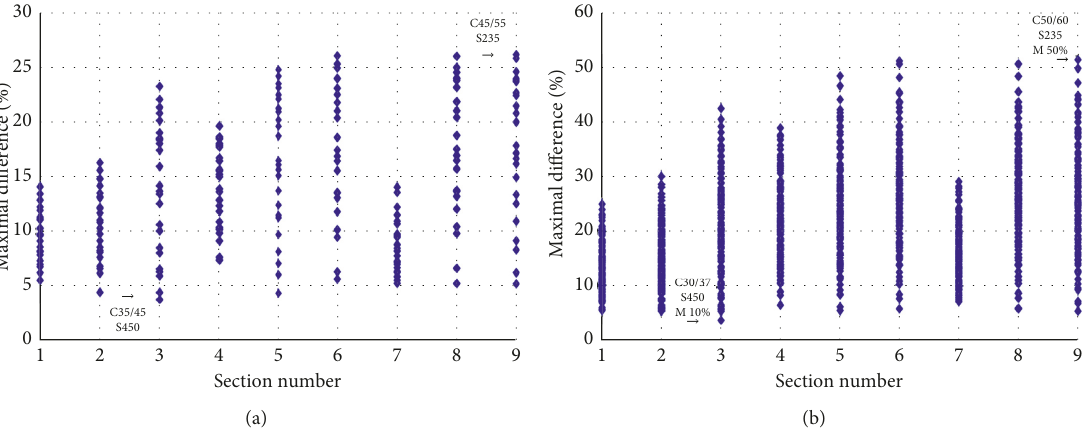
Figure 10: Maximal differences between nonlinear and linear solutions. (a) Propped constructional method and (b) unpropped con- structional method.